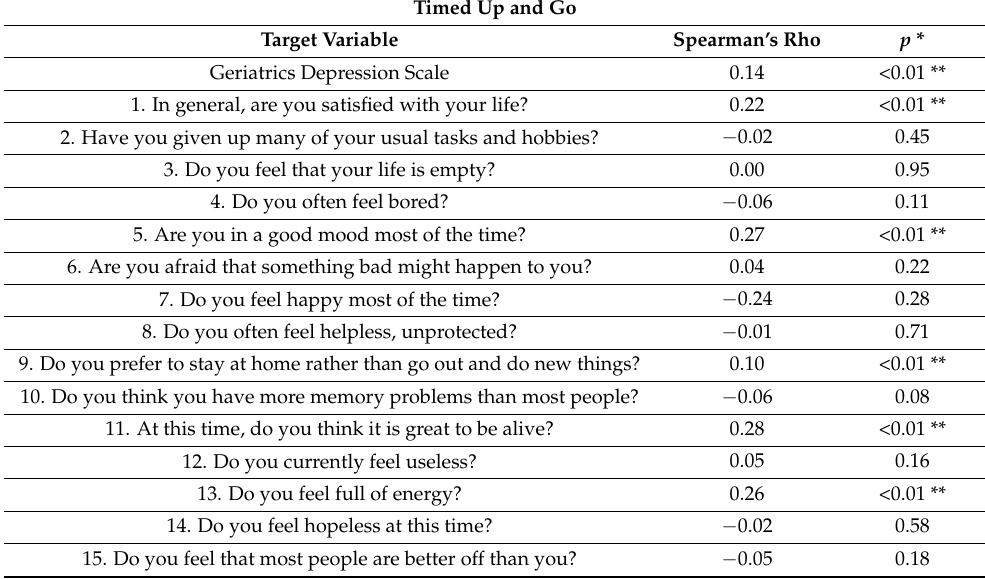
Table 2. Correlation between Timed Up and Go test and GDS in physically active older women with depression ( n = 685).